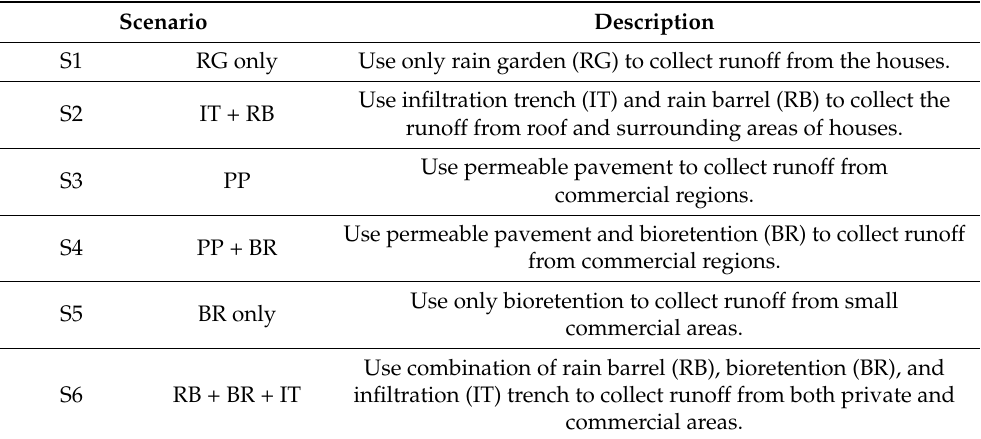
Table 4. Hypothetical LID scenarios to evaluate the effectiveness of redesigning the existing LIDs. Scenario